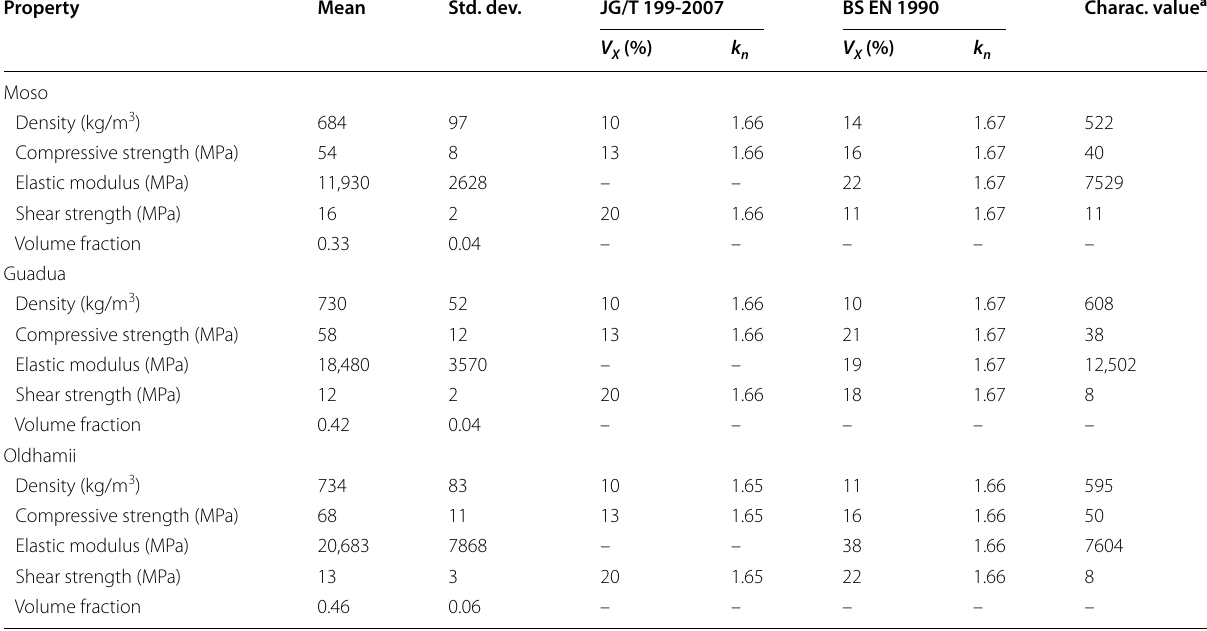
Table 3 Summary of results